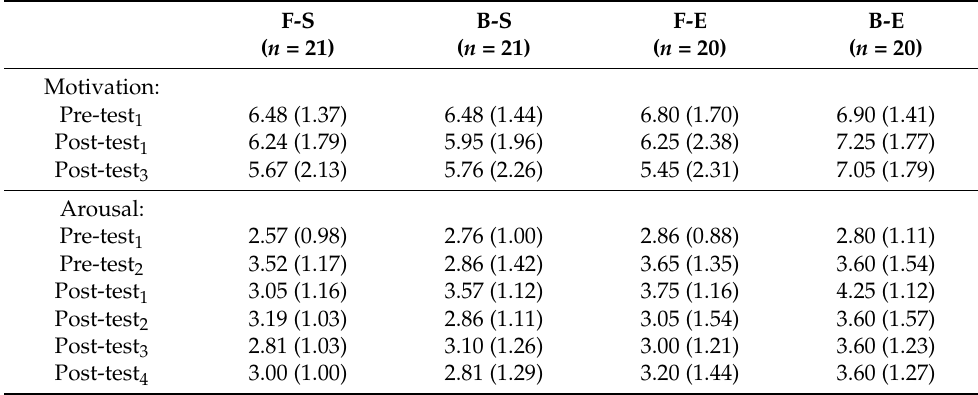
Table A2. Subjective ratings of arousal, feeling, motivation, and mental effort across the morning based on subjective